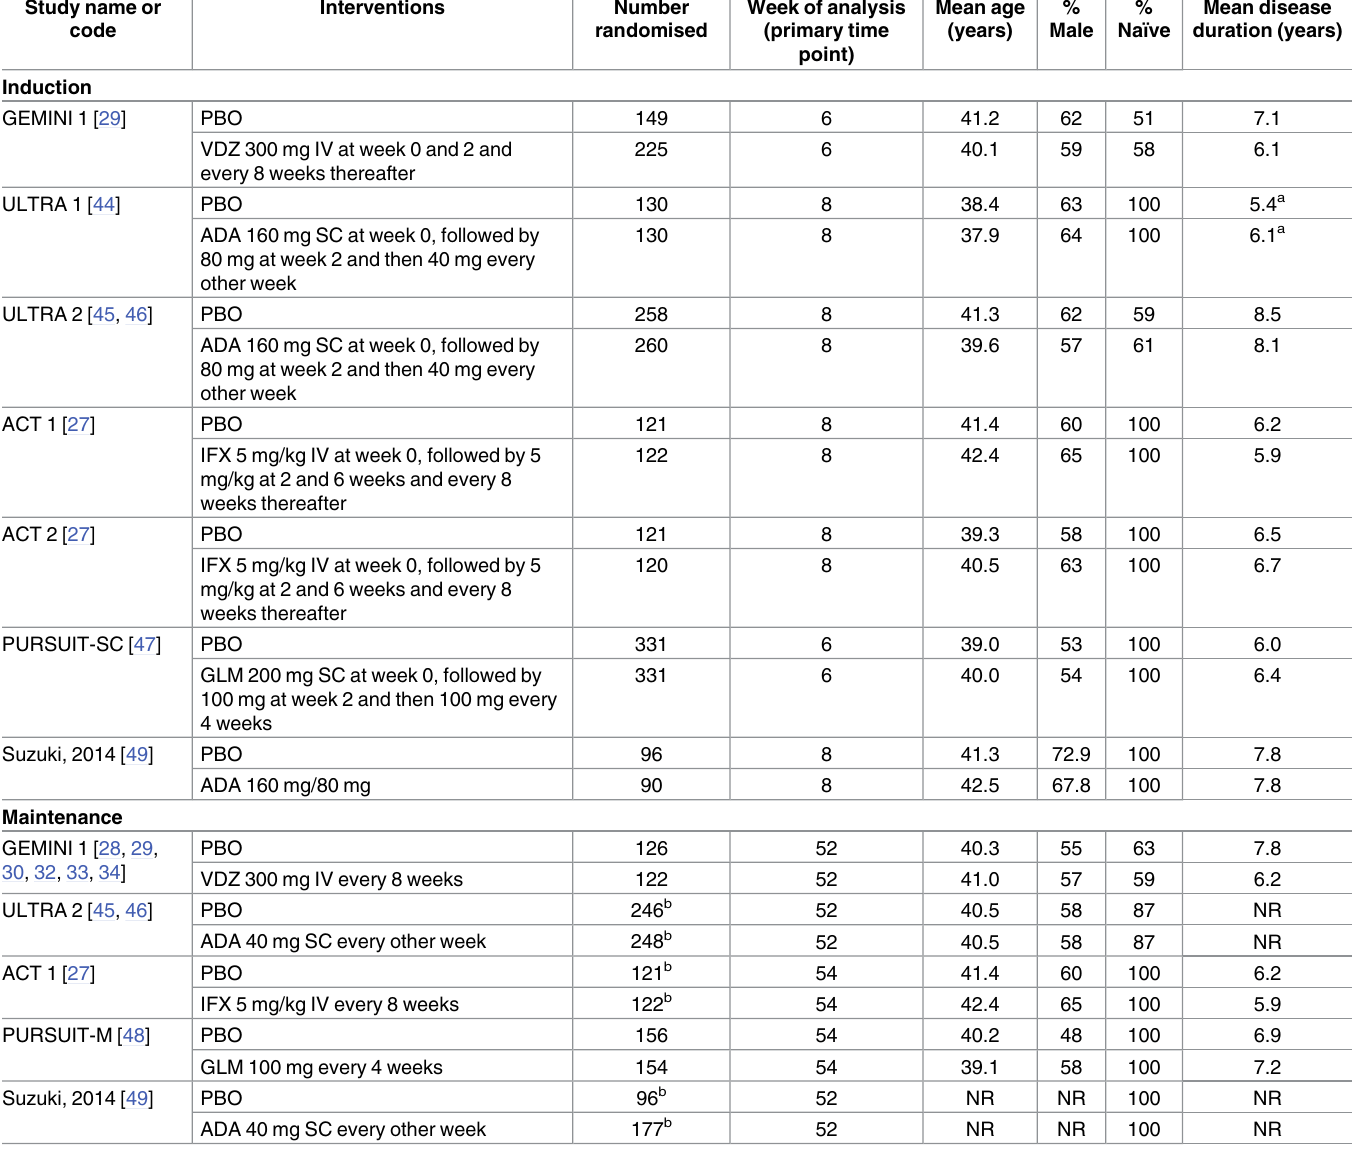
Table 1. Included trials/treatments and important patient